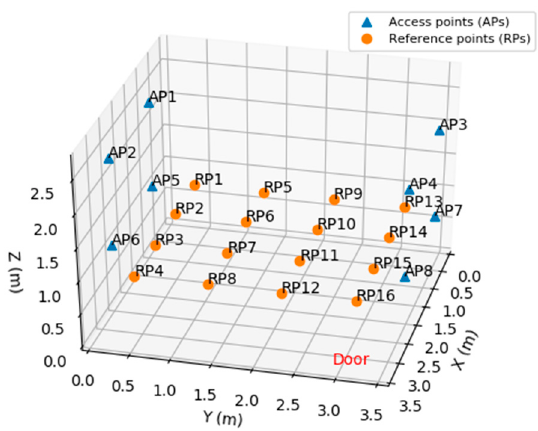
Figure 3. Positioning of access points (APs) and reference points (RPs).